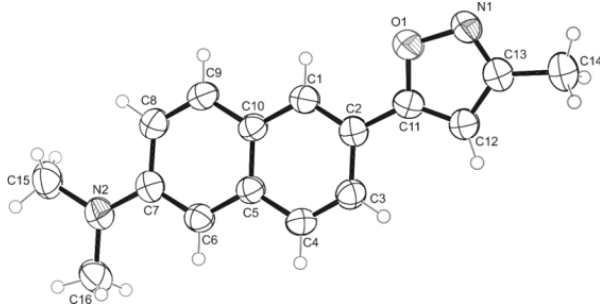
Figure 3. ORTEP drawing of compound 8 . For details please see the Supplementary